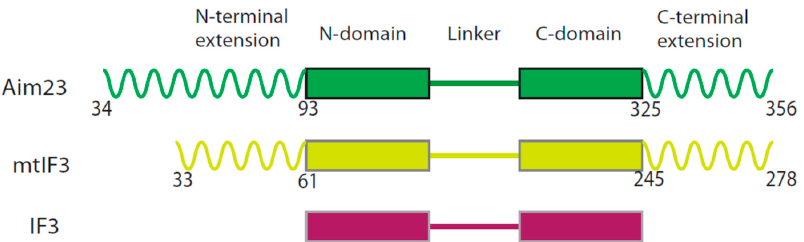
Figure 1. Domain organization of translation initiation factors 3 from yeast mitochondria (Aim23p, green), human mitochondria (mtIF3, yellowish green), and E. coli (IF3, dark red). Mitochondrial targeting sequences (MTSs) of Aim23p and mtIF3 are not shown as they are absent in the mature, functionally active protein forms. The main structural regions of the proteins are indicated on the top. Helices correspond to the terminal extensions, boxes correspond to the N- and C-domains and lines correspond to the linker regions. Characters are numbers of the amino acids circumscriptive of the indicated structural regions.